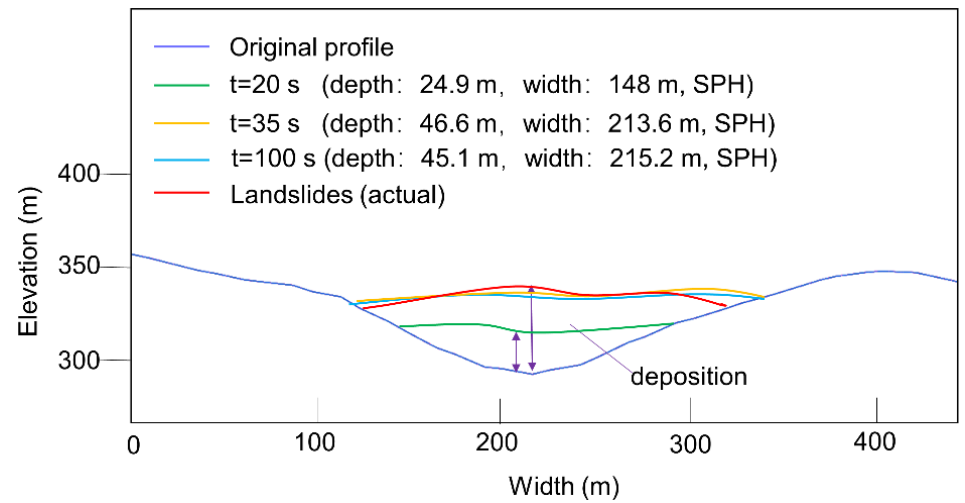
Figure 16. Comparison of profiles by the SPH simulation and the actual landslides along Section 3–3.